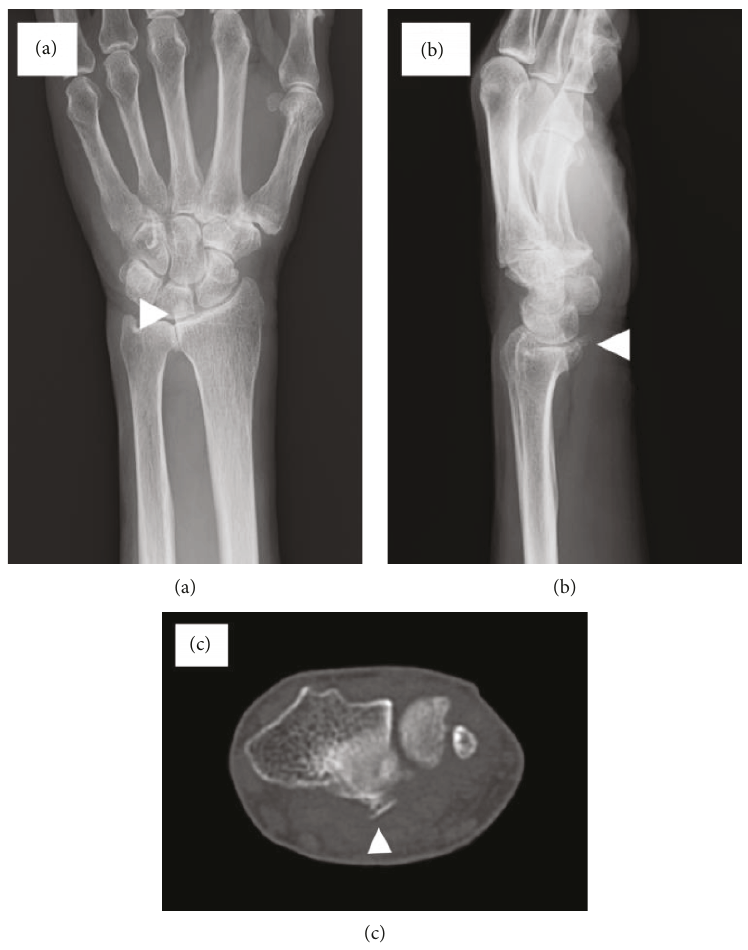
Figure 1: Clinical examination. (a) Bony spur on the anterior-posterior plain radiograph of the wrist joint (white arrowhead). (b) Bony spur on the lateral plain radiograph of the wrist joint (white arrowhead). (c) Bony spur on computed tomography (white